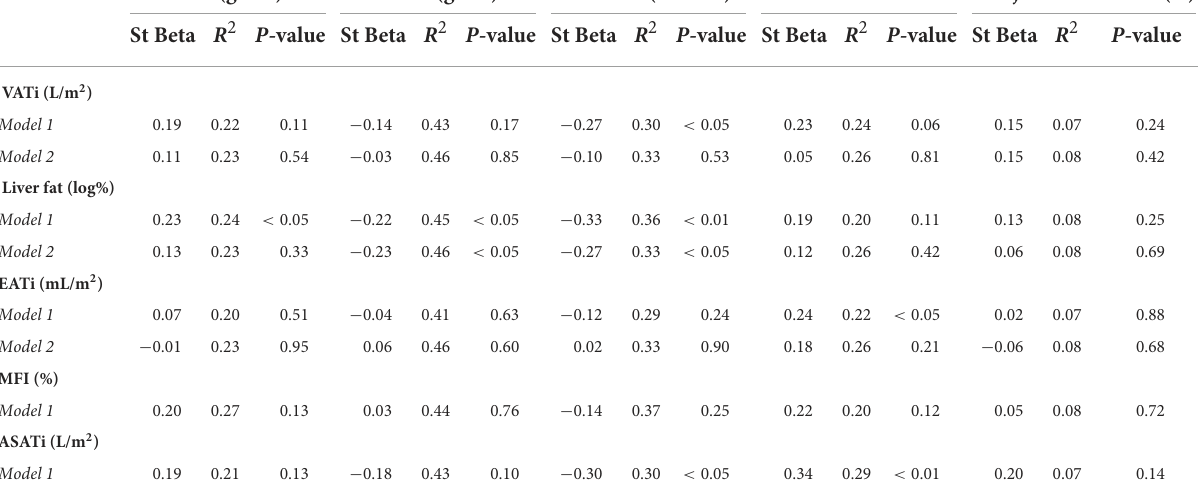
TABLE 4 Linear regression analyses using two different